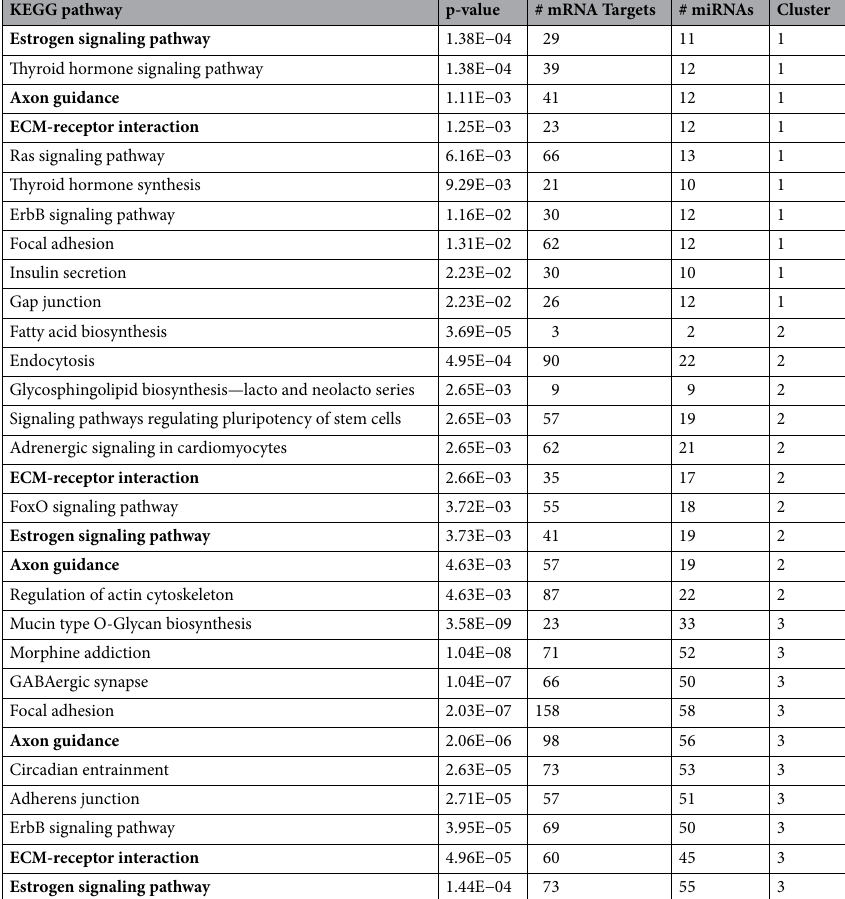
Table 5. Top 10 FDR Significant, non-cancer related, KEGG Pathways associated with the human milk extracellular vesicle miRNAs in clusters 1, 2 and 3 determined with DIANA microT-CDS. KEGG Kyoto Encyclopedia for genes and genomes, FDR false discovery rates. Bold: Pathways shared between all